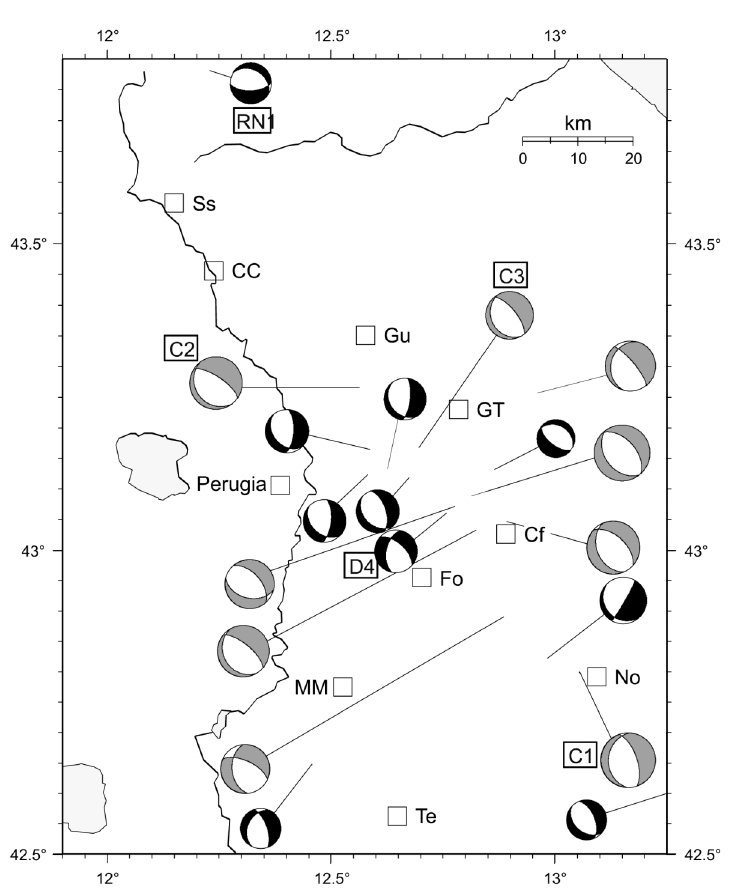
Fig. 3. Map of moment tensors available for the study region. Grey focal mechanisms are from the Harvard CMT Catalog (1977-2000); black focal mechanisms are from the present study.